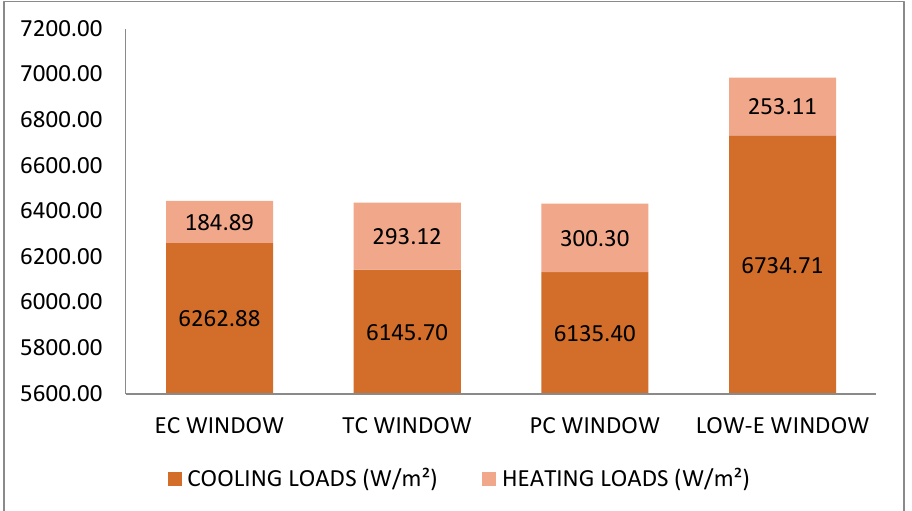
Figure 12 Total energy uses for heating and cooling for August 14 and February